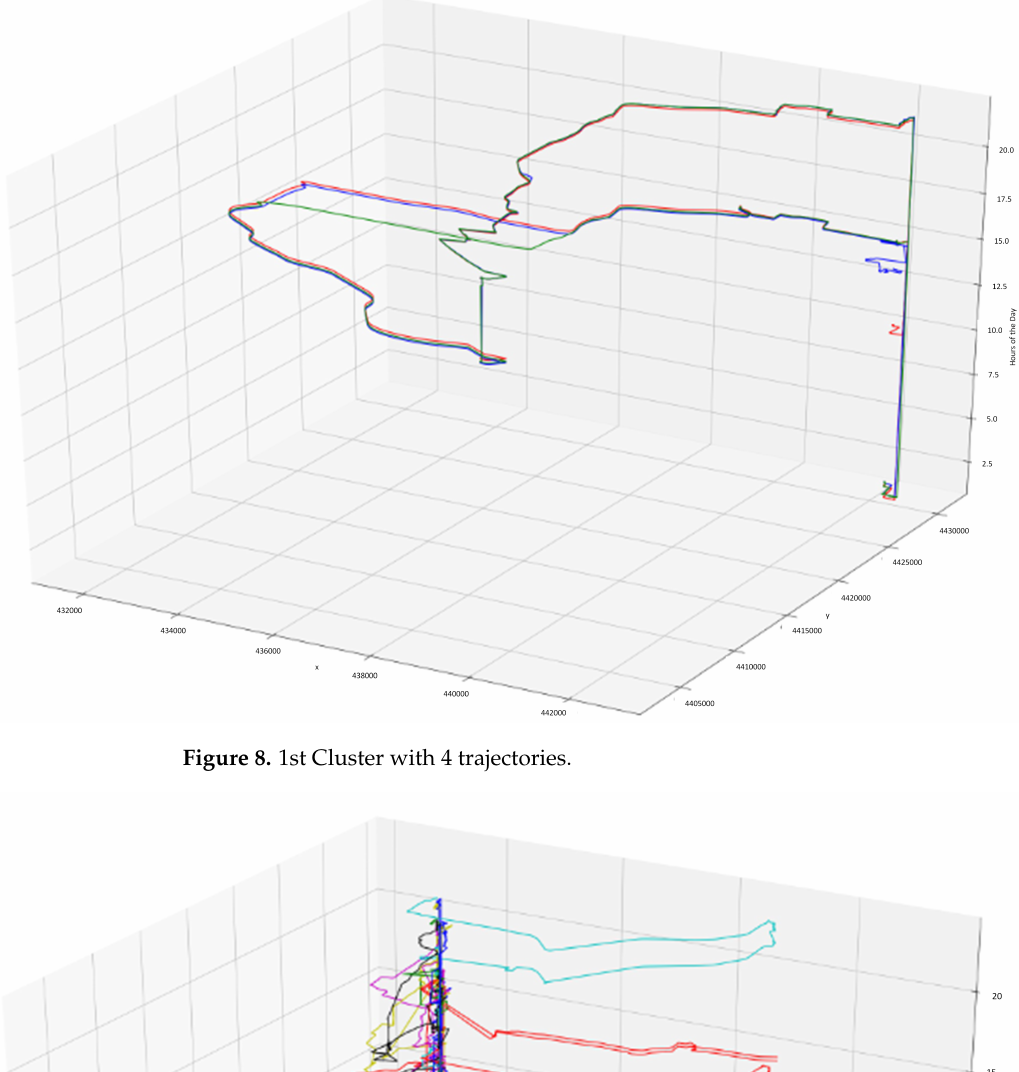
Figure 8. 1st Cluster with 4 trajectories.